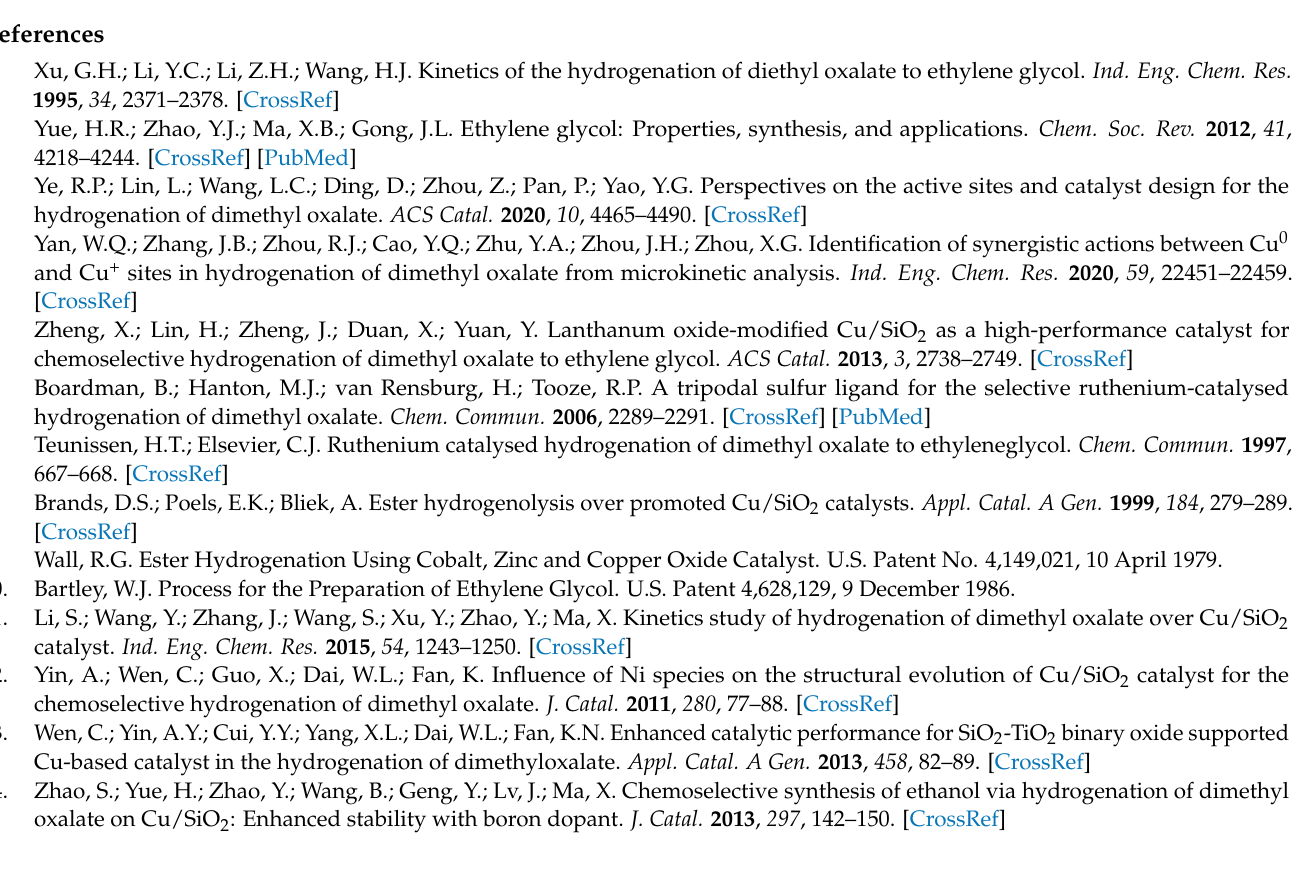
Table S3: Physicochemical properties of different catalysts; Figure S2: TEM images of the MOF-CmS catalyst. Figure S3: Long-term stability test of the MOF-CmS sample at a reaction temperature of 200 ◦ C and WLHSV DMO of 0.82 h − 1 . Figure S4: Reaction tube diagram; Reference [40] is cited in the supplementary